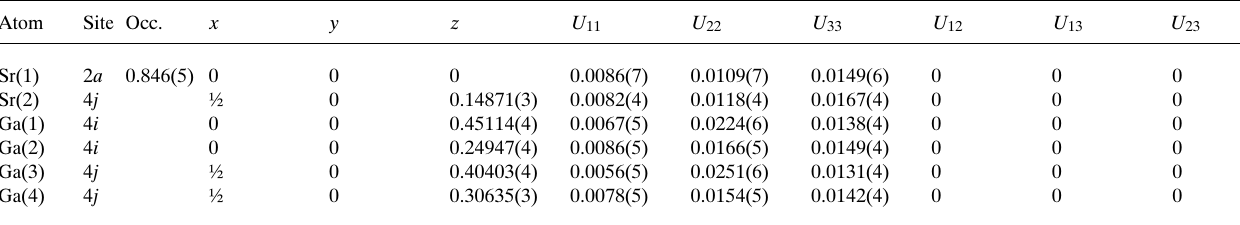
Table 3. Atomic coordinates and displacement parameters (in Å 2 ) .